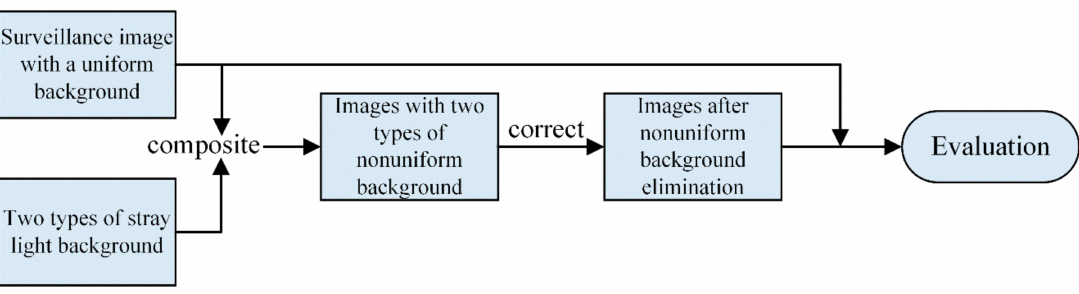
Figure 7. Flowchart of the simulation image experiment.